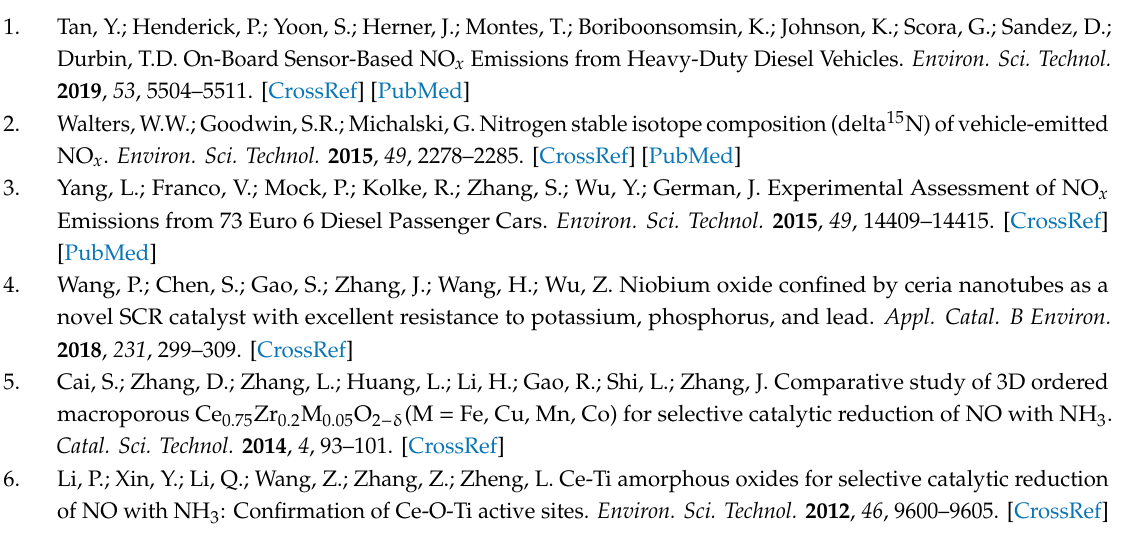
Figure S1: Concentration of N 2 O produced by the prepared catalysts under NH 3 -SCR conditions. Figure S2: SEM images of prepared catalysts. (a) Cu-SSZ-13, (b) 3% Mn / Cu-SSZ-13, (c) 5% Mn / Cu-SSZ-13, (d) 7% Mn / Cu-SSZ-13, (e) 10% Mn / Cu-SSZ-13, (f) 14% Mn / Cu-SSZ-13. Figure S3: EDX results of catalysts. (a) Cu-SSZ-13, (b) 5% Mn / Cu-SSZ-13. Figure S4: XRD patterns of Cu-SSZ-13 catalysts with and without Mn impregnation. Figure S5: XPS spectra of catalysts. (a) Cu 2p spectra of Cu-SSZ-13 and 5% Mn / Cu-SSZ-13, (b) Mn 2p spectra of 5% Mn / Cu-SSZ-13. Figure S6: Integrated NH 3 desorption amounts per 1 g of catalyst, calculated from NH 3 -TPD results. Figure S7. XRD patterns of 5% Mn / Cu-SSZ-13 catalysts before and after being